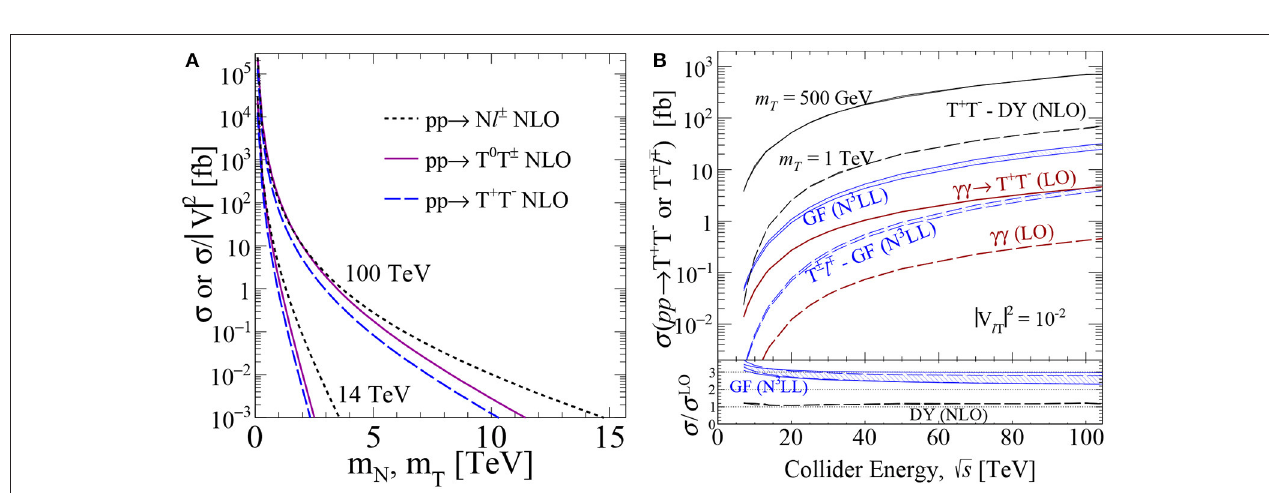
14 and 100 TeV. (B) As a function =